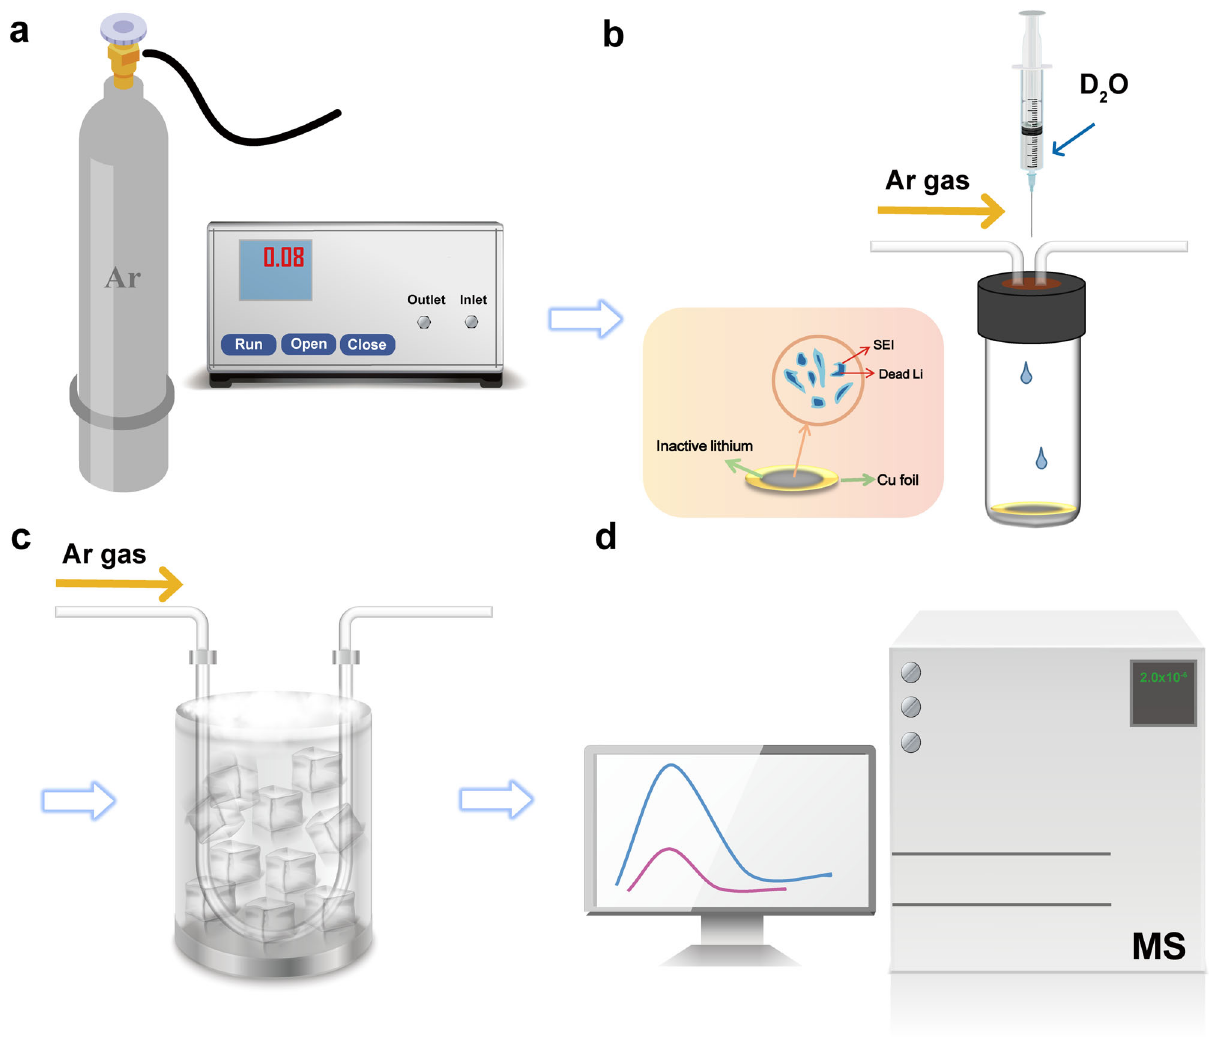
Fig. 1 Schematic illustration of mass spectrometry titration system for quanti fi cation of inactive lithium. a Carrier gas cylinder and mass fl ow controller. b The sealed titration gas analysis installation. c Condensing installation. d The mass